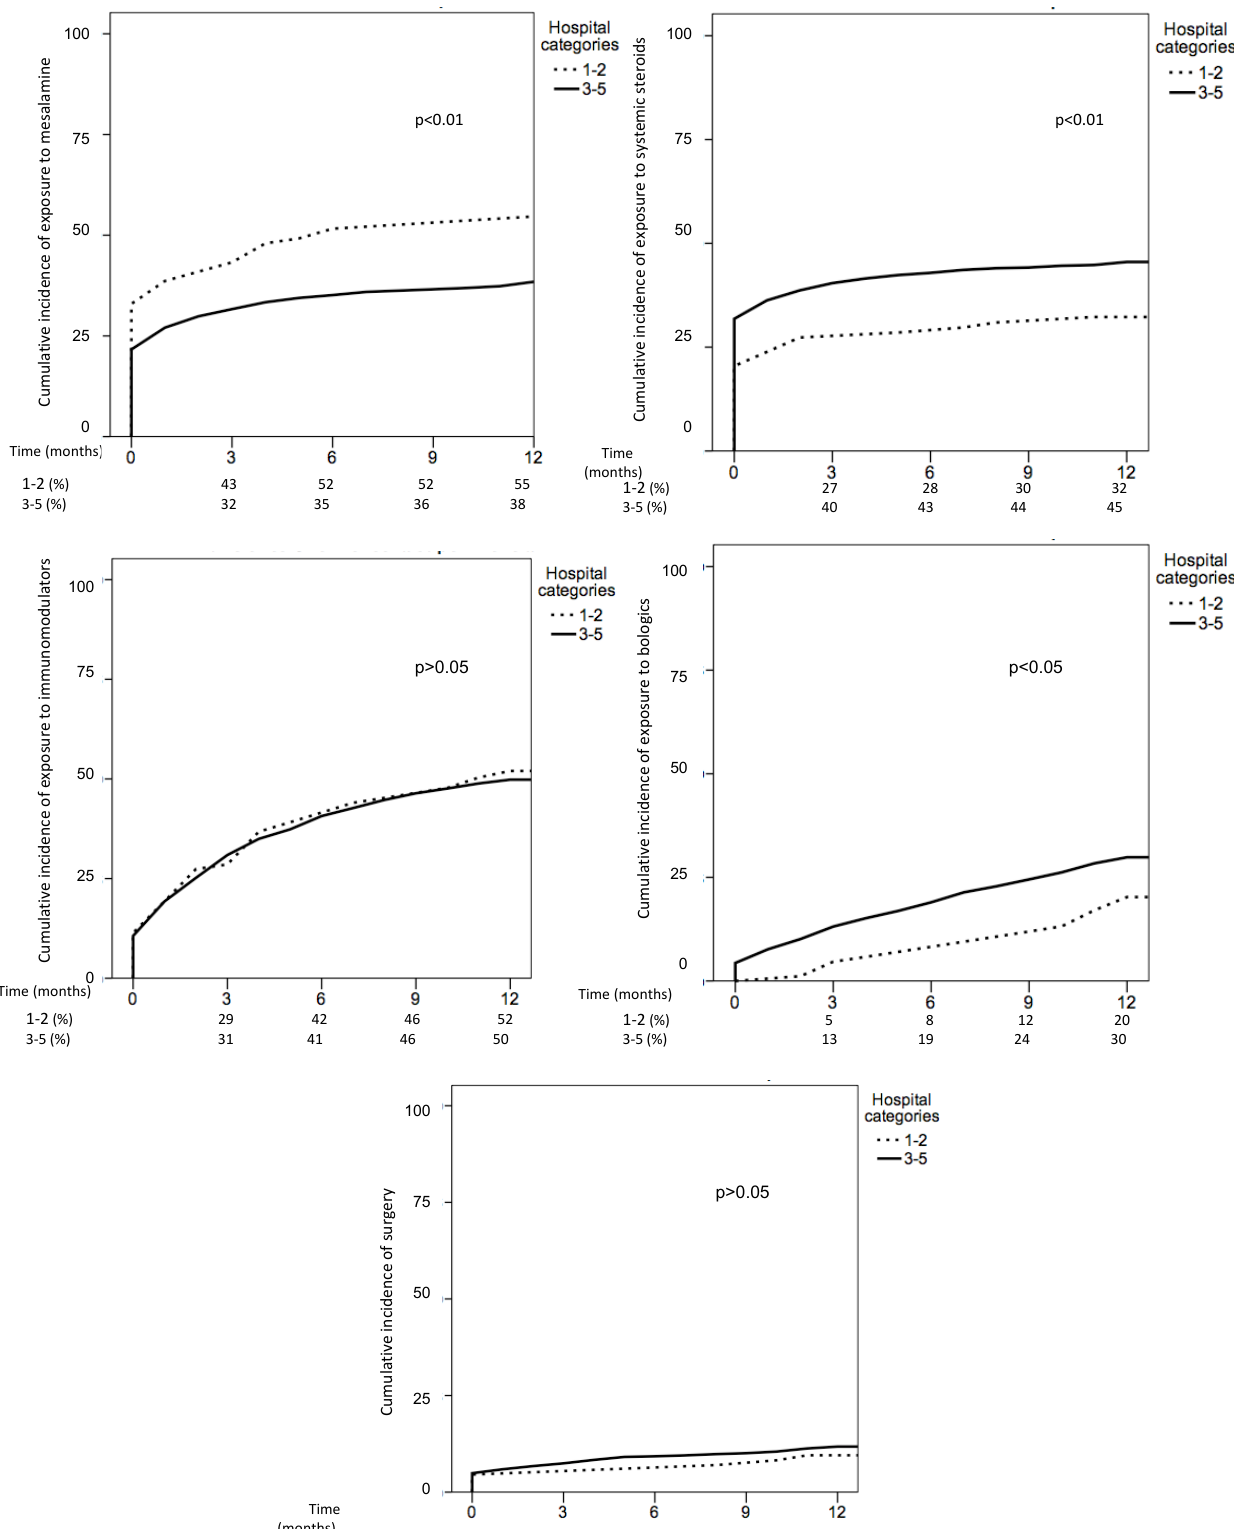
Figure 2. Cumulative incidence of exposure to treatments in Crohn’s disease (CD) based on hospital categories: low resources (1 and 2) vs. high resources (3-5).